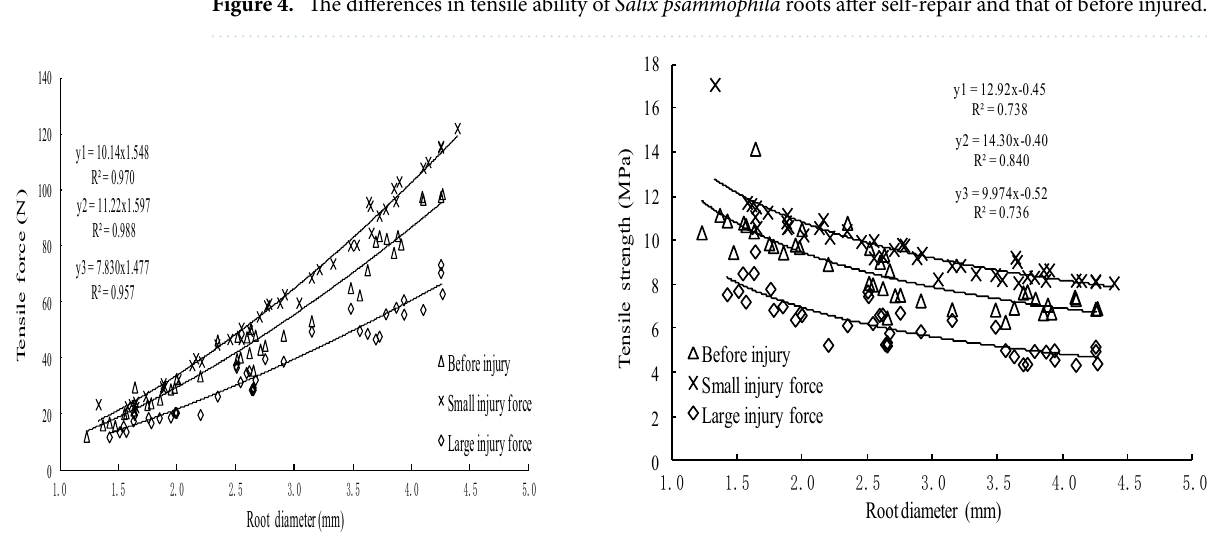
Figure 5. The differences in tensile ability of Hippophae rhamnoides L. roots after self-repair and that of before